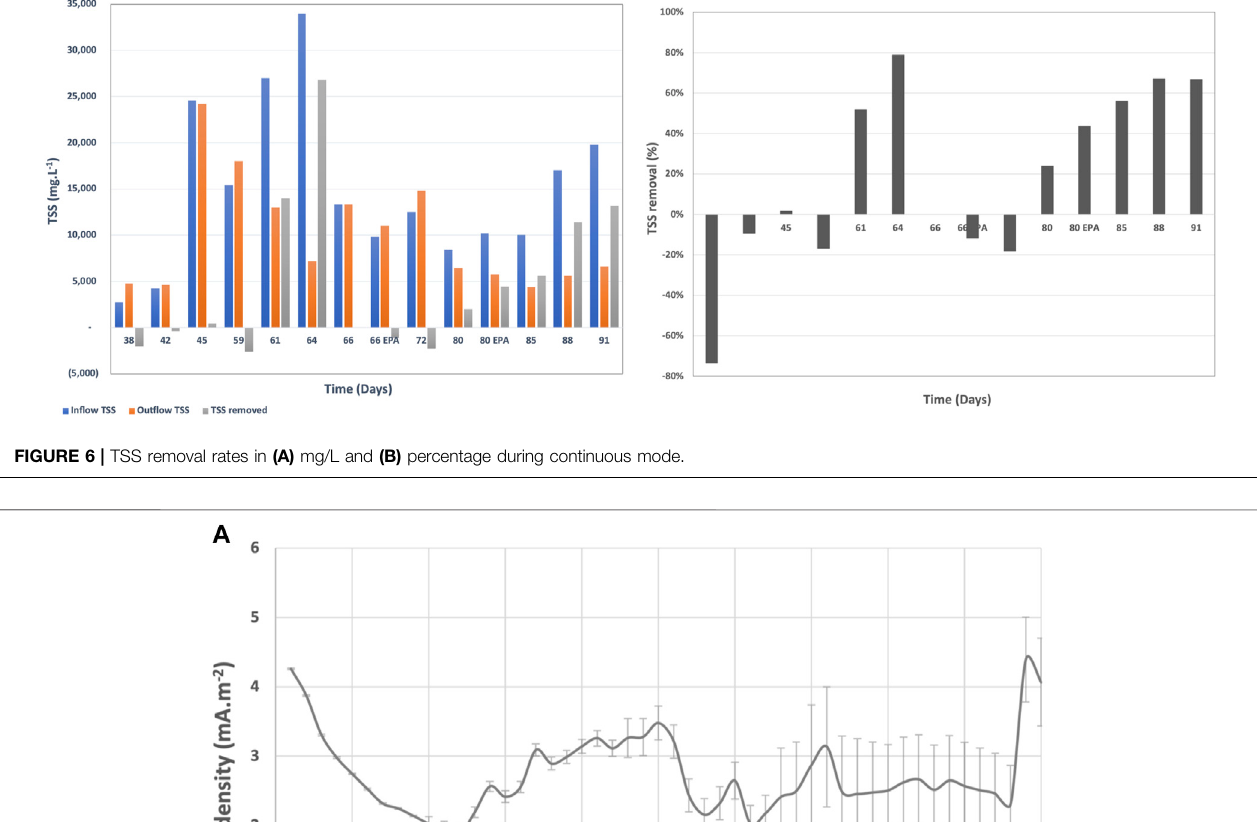
Frontiers in Chemical Engineering | www.frontiersin.org May 2022 | Volume 4 | Article 832505